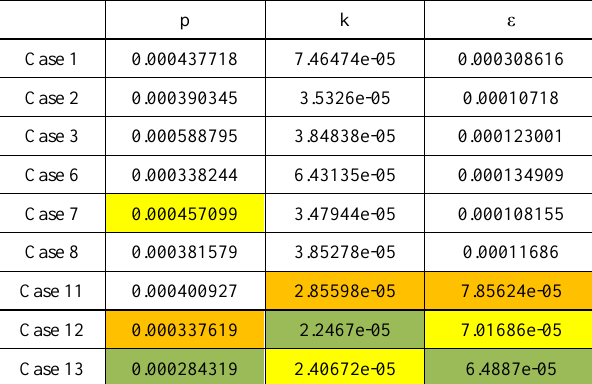
Table 3. Final residuals of CFD process per mesh case. Green = best result in column, Yellow = 2 nd best result and Orange = 3 rd best result